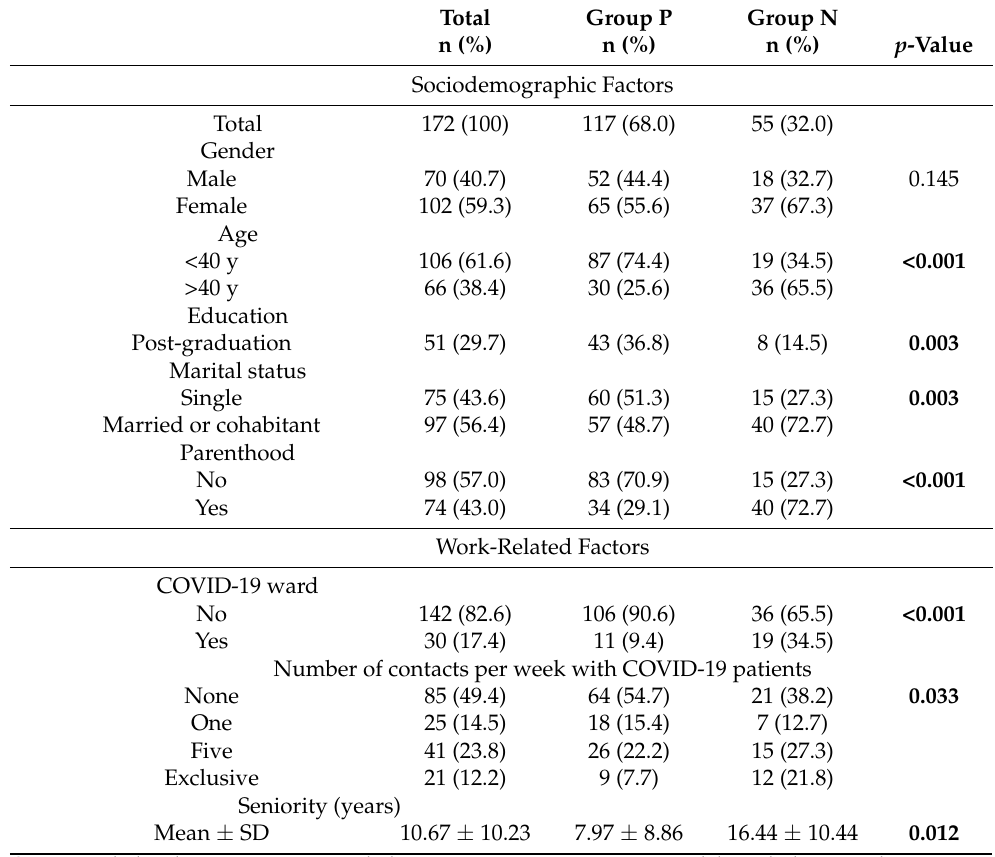
Table 1. Description of study population: sociodemographic characteristics and work-related factors (n = 172). Total Group P Group N n (%) n (%) n (%) p